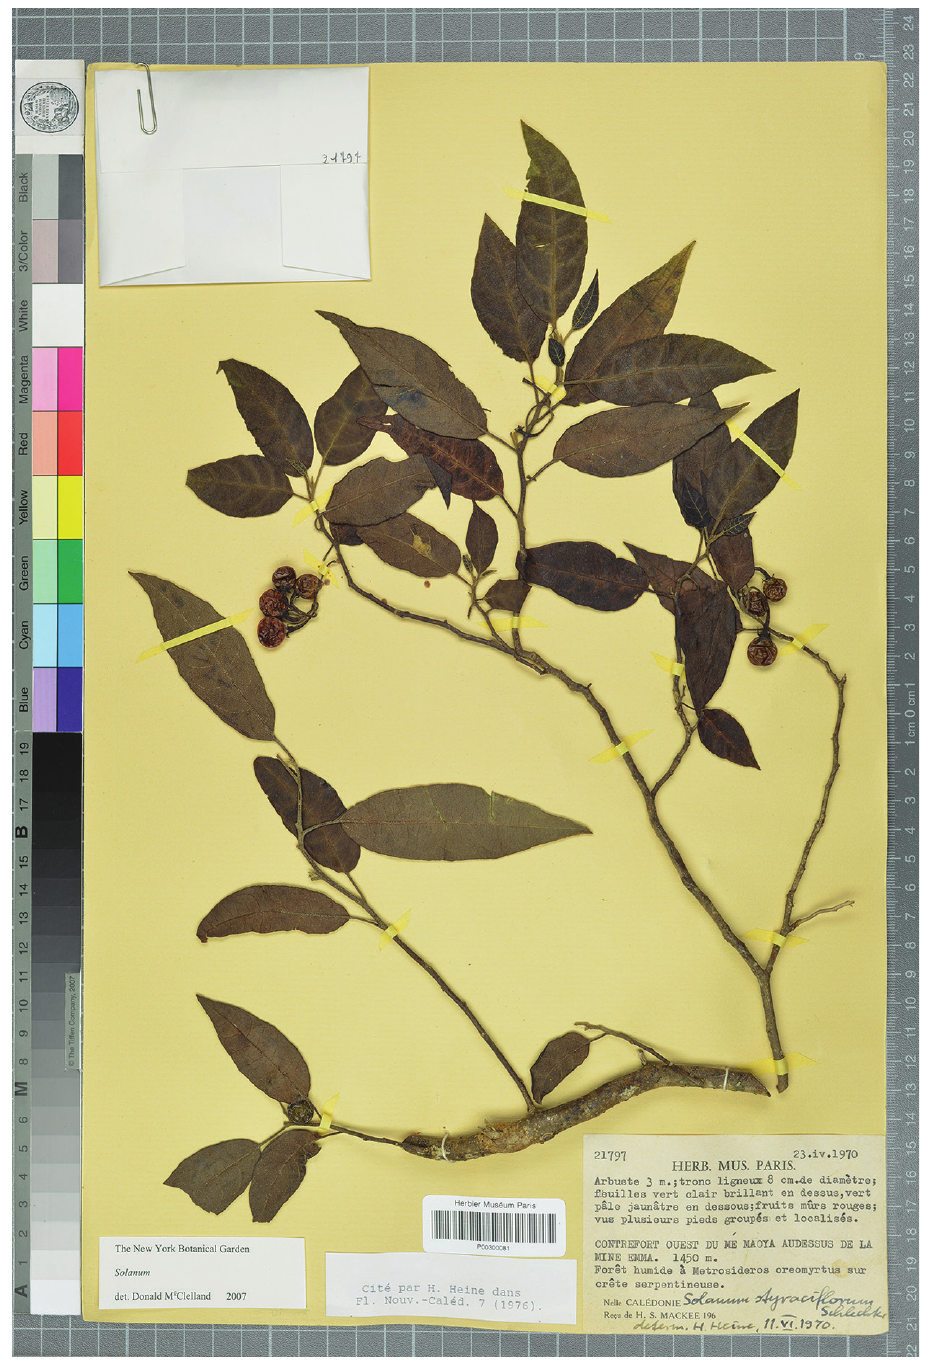
Figure 6. Solanum memoayanum D.McClelland (isotype MacKee 21797 , P [P00300081]). Reproduced with